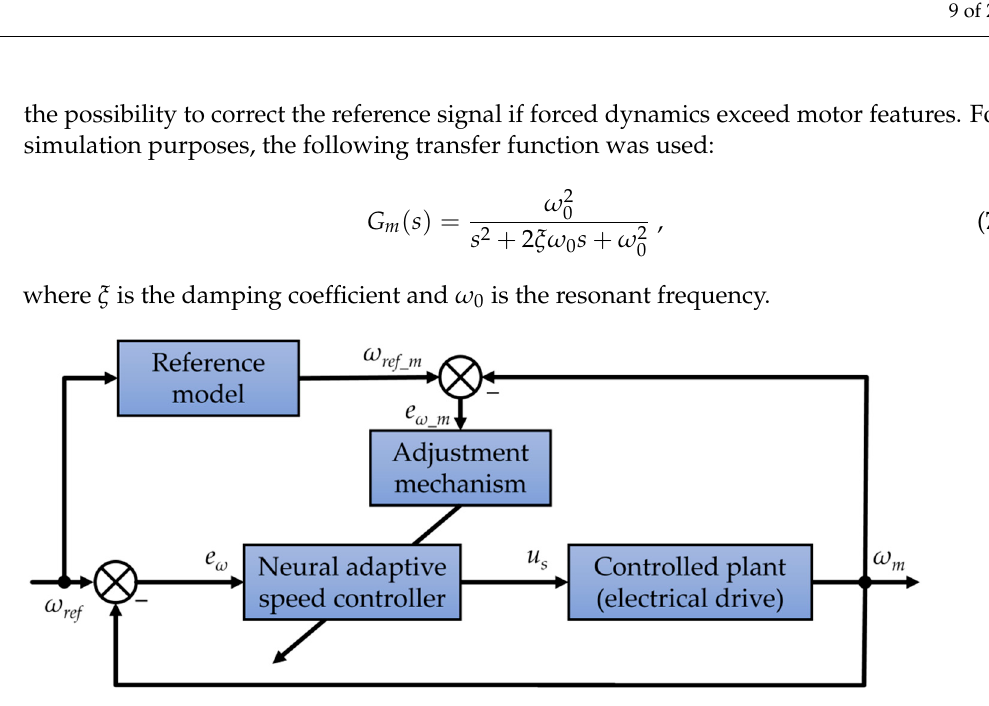
Figure 8. Neural adaptive control structure with reference model.